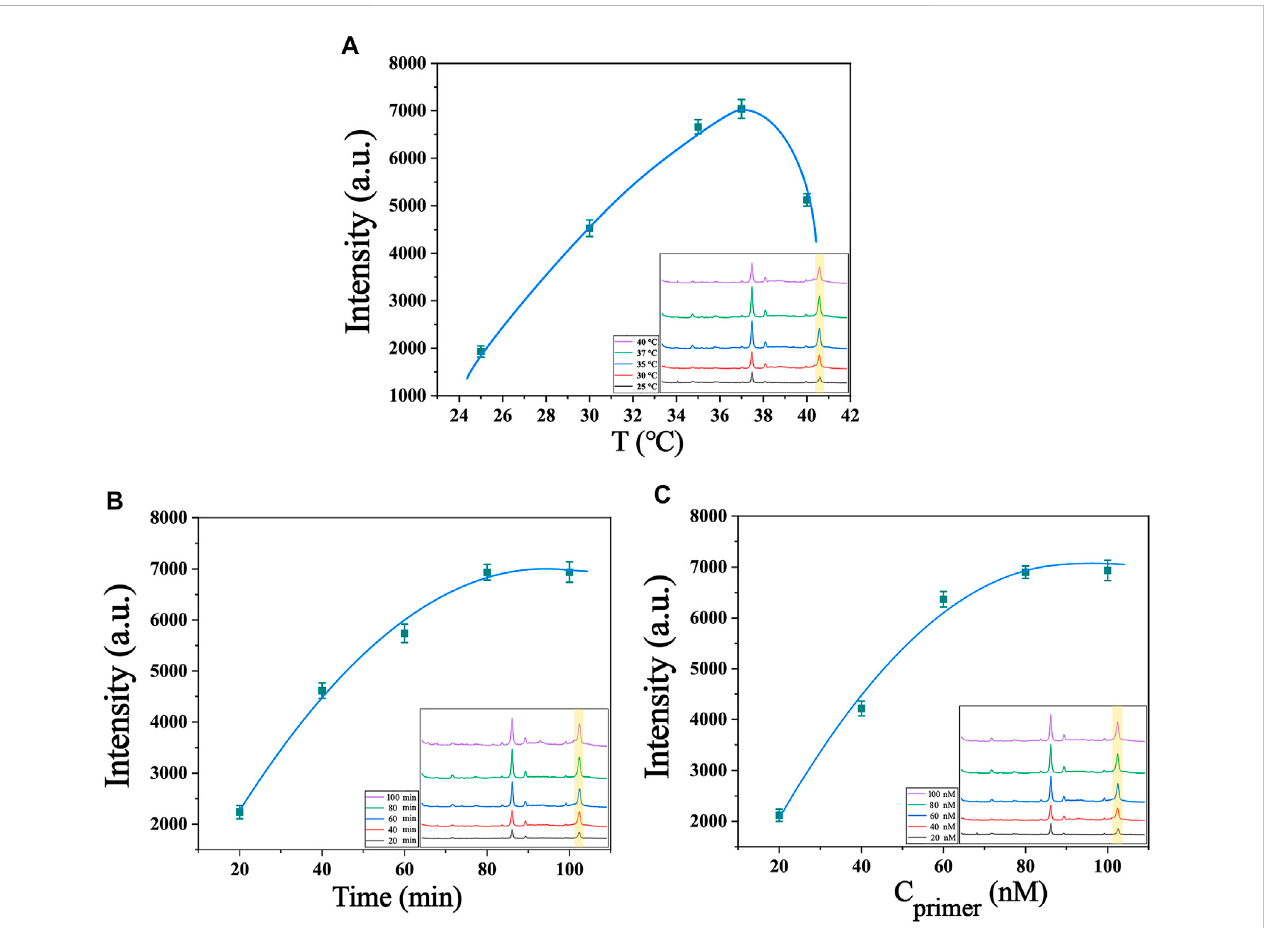
FIGURE 4 Optimization of experimental conditions (A) Optimization of the temperature of the system (telomerase concentration of 1.0 × 10 − 2 IU/mL). (B) Optimization of the reaction time of the system (telomerase concentration of 1.0 × 10 − 2 IU/mL). (C) Optimization of primer ’ s concentration of the system (telomerase concentration of 1.0 × 10 − 2 IU/mL). The inset in the lower right corner shows their SERS spectra.